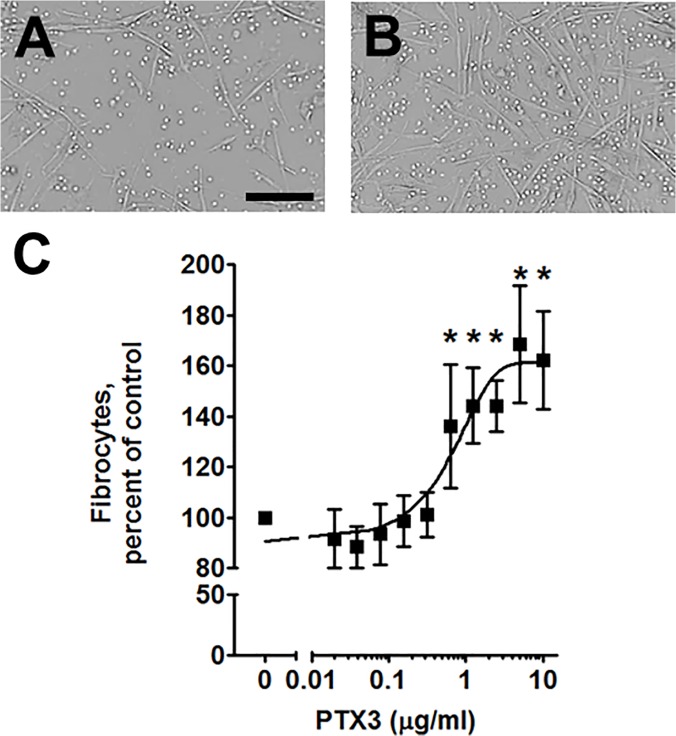
PTX3 promotes fibrocyte differentiation.Human PBMC were incubated for 5 days in the absence A) or presence B) of 1 μg/ml PTX3. Bar is 50 μm. C) The effect of the indicated concentrations of PTX3 on fibrocyte numbers. For each donor, numbers were normalized to the no-PTX3 control. Values are mean ± SEM (n = 4). *p <0.05 (t-test). Line is a fit to a sigmoidal dose response curve.